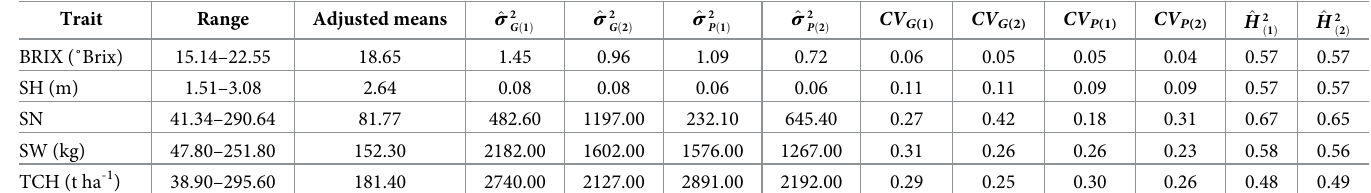
Table 1. Ranges, adjusted means, estimates of components of genetic variance ( ^ σ 2 notypic variation (CV R ), and broad-sense heritability on an individual-plant basis ( ^ H 2 ) for BRIX, SH, SN, SW and TCH for the BPSG over two harvest years (plant cane (1) and first ratoon (2)).